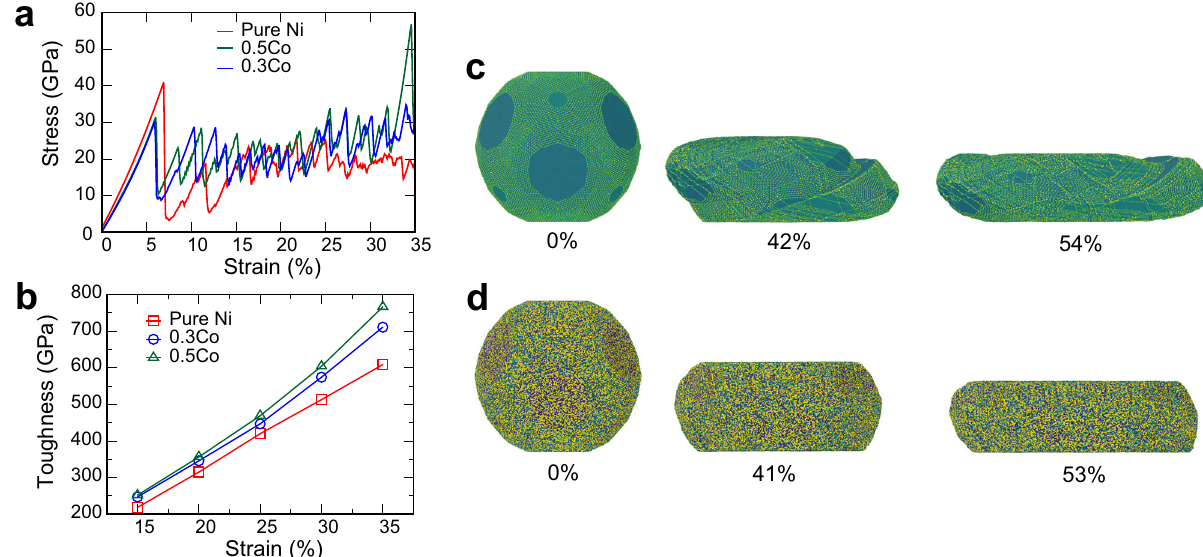
Fig. 7 Alloying increases the nanoparticle toughness. a Example of stress-strain curves for 35 nm nanoparticles deformed up to the strain of 350.5Co. b Toughness of 35 nm nanoparticles as a function of strain. c – d Deformed shapes of the c Ni and d Ni-0.5Co 35 nm nanoparticles. The atoms are colored according to potential energy, with brighter colors representing larger energy. The strain is indicated under the